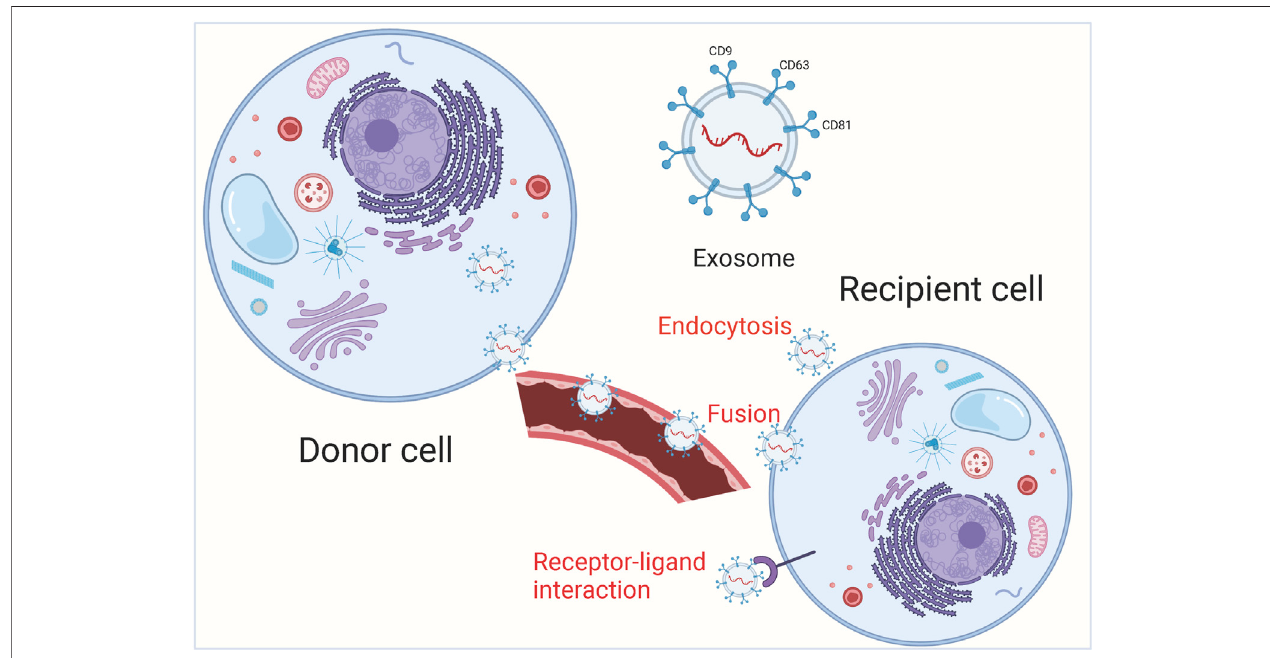
FIGURE 1 | The main process of exosome release. Exosomal cargoes from the source cell can be further delivered to recipient cells via endocytosis, direct membrane fusion and receptor-ligand interaction.